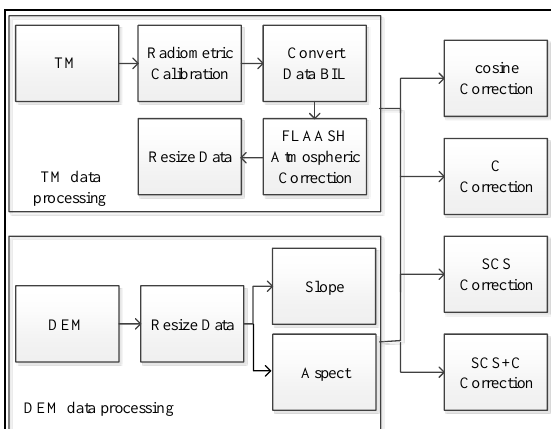
Figure 1. TM and DEM data